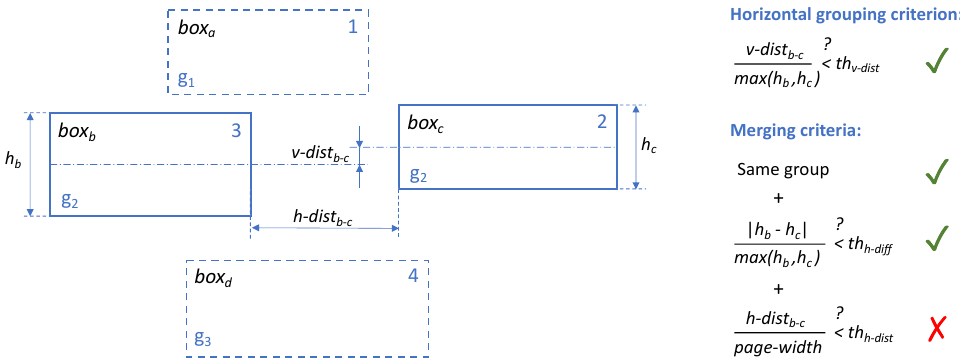
Figure 3. Visual example for horizontal box grouping and merging criteria: box b and box c are grouped into the same horizontal group ( g 2 ) but are not merged. Groups are shown on the bottom left corner of each box. The resulting box numbering is shown on the top right corner of each